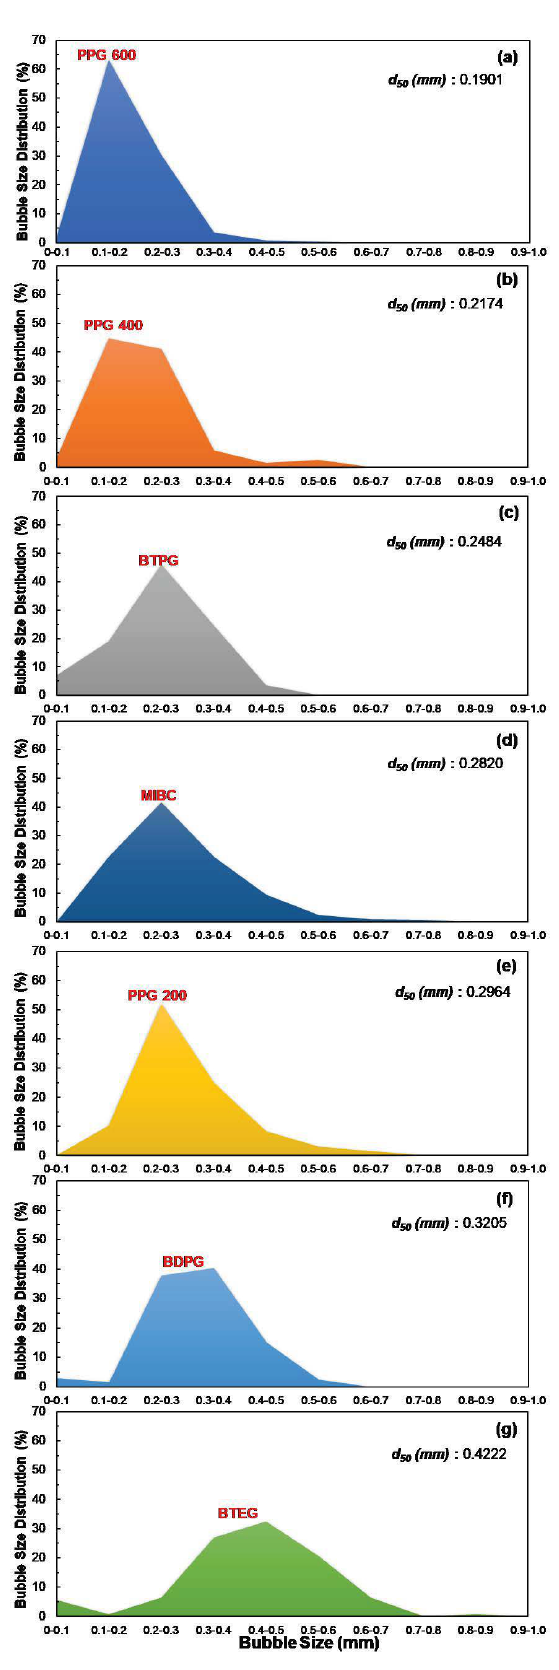
Figure 6. Effect of frother type on BSD at 50 ppm frother concentration, 50 cm 3 /min air flowrate, and 10–16 µ m frit pore size: ( a ) PPG 600 ( b ) PPG 400 ( c ) BTPG ( d ) MIBC ( e ) PPG 200 ( f ) BDPG ( g )